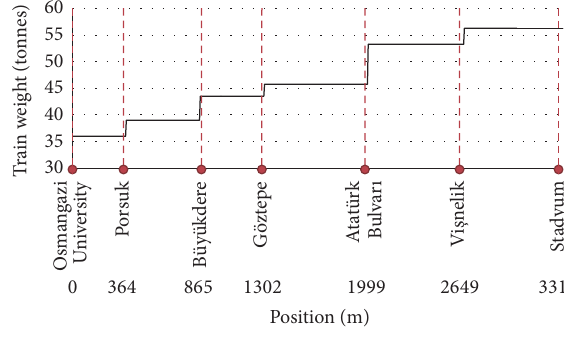
Figure 7: Train mass for each station.